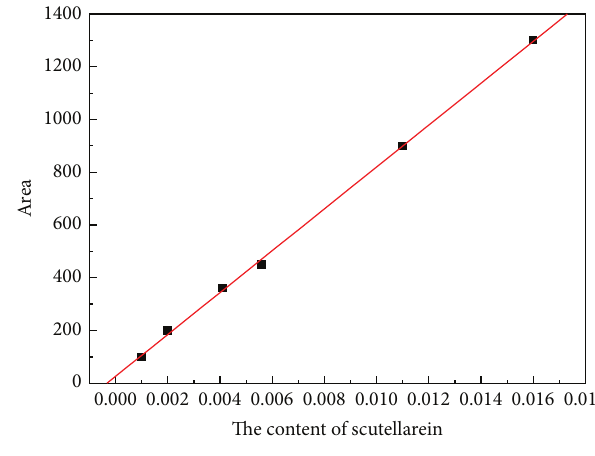
Figure 2: Scutellarein standard